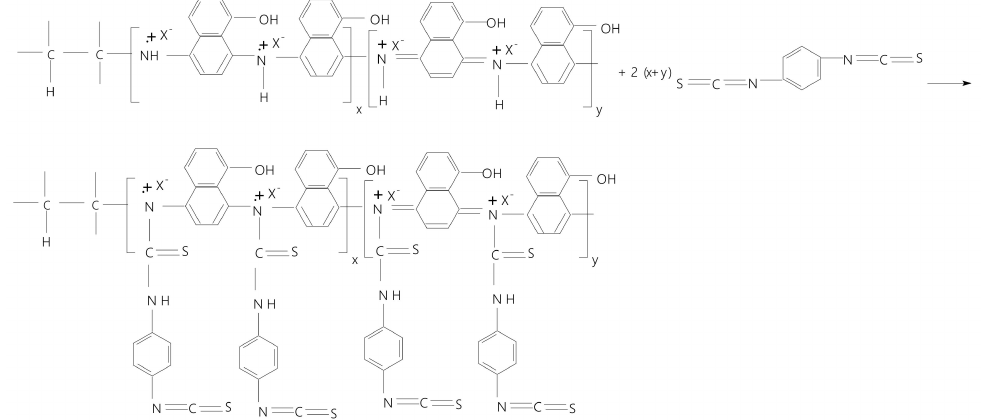
Figure 12. The IR spectra of PDITC (green curve) before and after the adsorption onto the blank Au electrode ( a ) and the Au electrode covered with the RGO sheets covalently functionalized with P5A1N doped with H 4 SiW 12 O 40 heteropolyanions ( b ) using 2 mL (red curve), 1 mL (black curve) and 0.5 mL (blue curve) of the PDITC in C 2 H 5 OH solution with the concentration of 1 mg / mL.